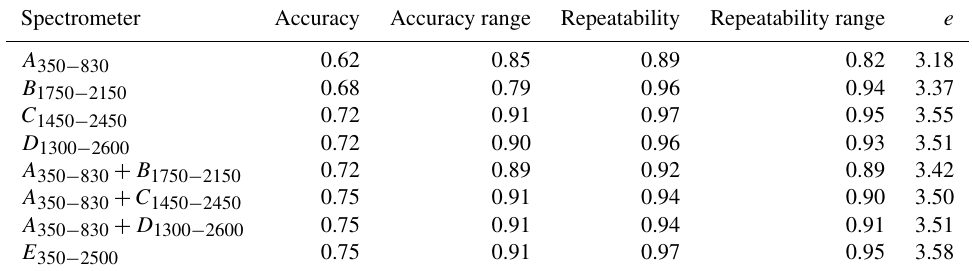
Figure 6. Effect of the repeatability of the spectrometers on the spectroscopic modelling. (cid:49)ρ c represents the difference in ρ c between the algorithms (with PSLR, Cubist, GPRL, and GPRP) of the replicates. The discs show the mean difference, and the lines represent the minimum and maximum of the difference. A small (cid:49)ρ c indicates good repeatability. Table 4. Overall assessment of the spectrometers and combinations. Columns show the accuracy and the stability (represented by the range of the accuracy) of the spectrometers when modelling with the different algorithms (PSLR, Cubist, GPRL, and GPRP) as well as the effect of the spectrometers’ repeatability on the modelling and its stability. They correspond to the first, second, third, and fourth term in Eq. (2),